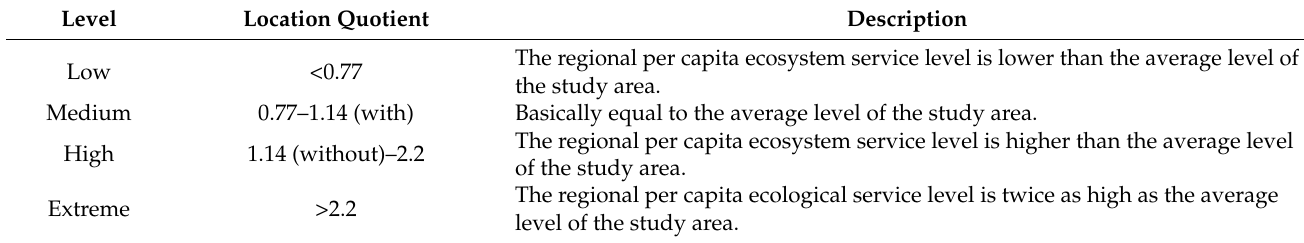
Table 2. The classification standard of the location quotient